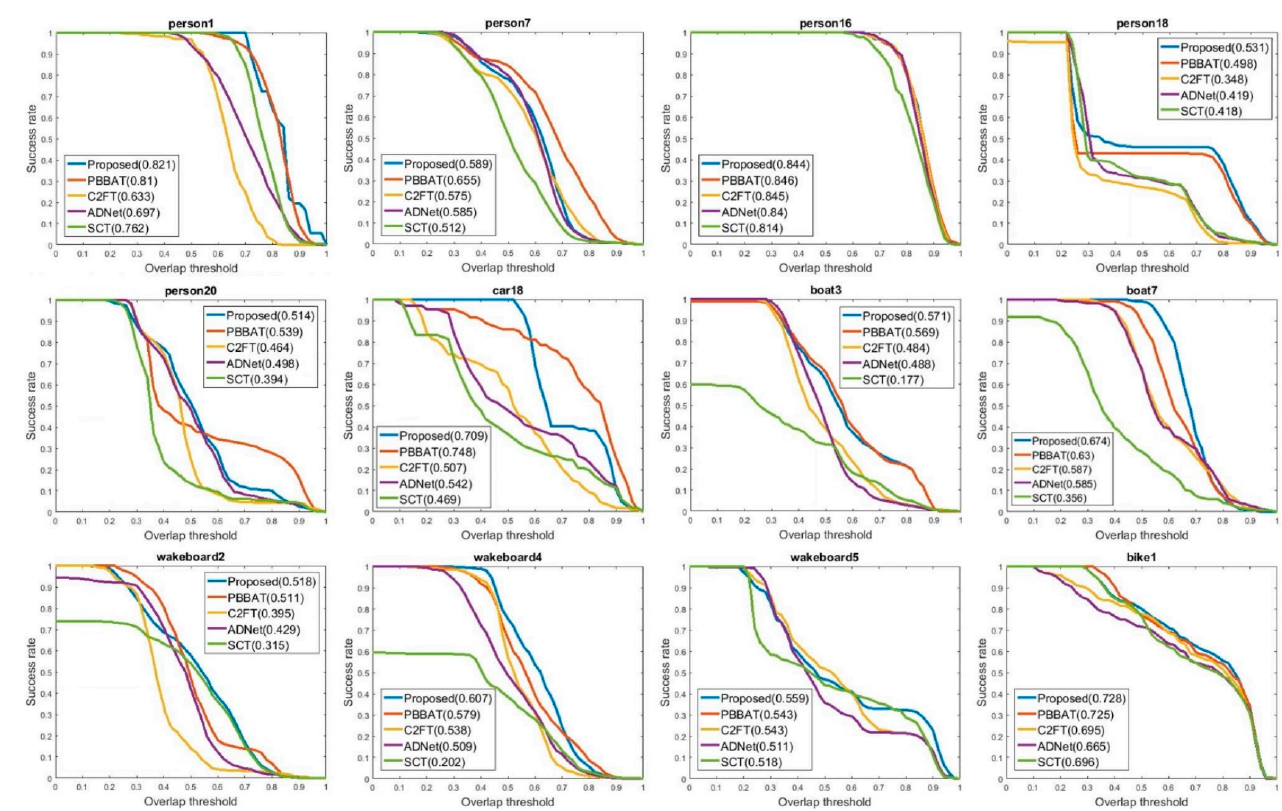
Figure 18. The success plot of OPE on UAV123